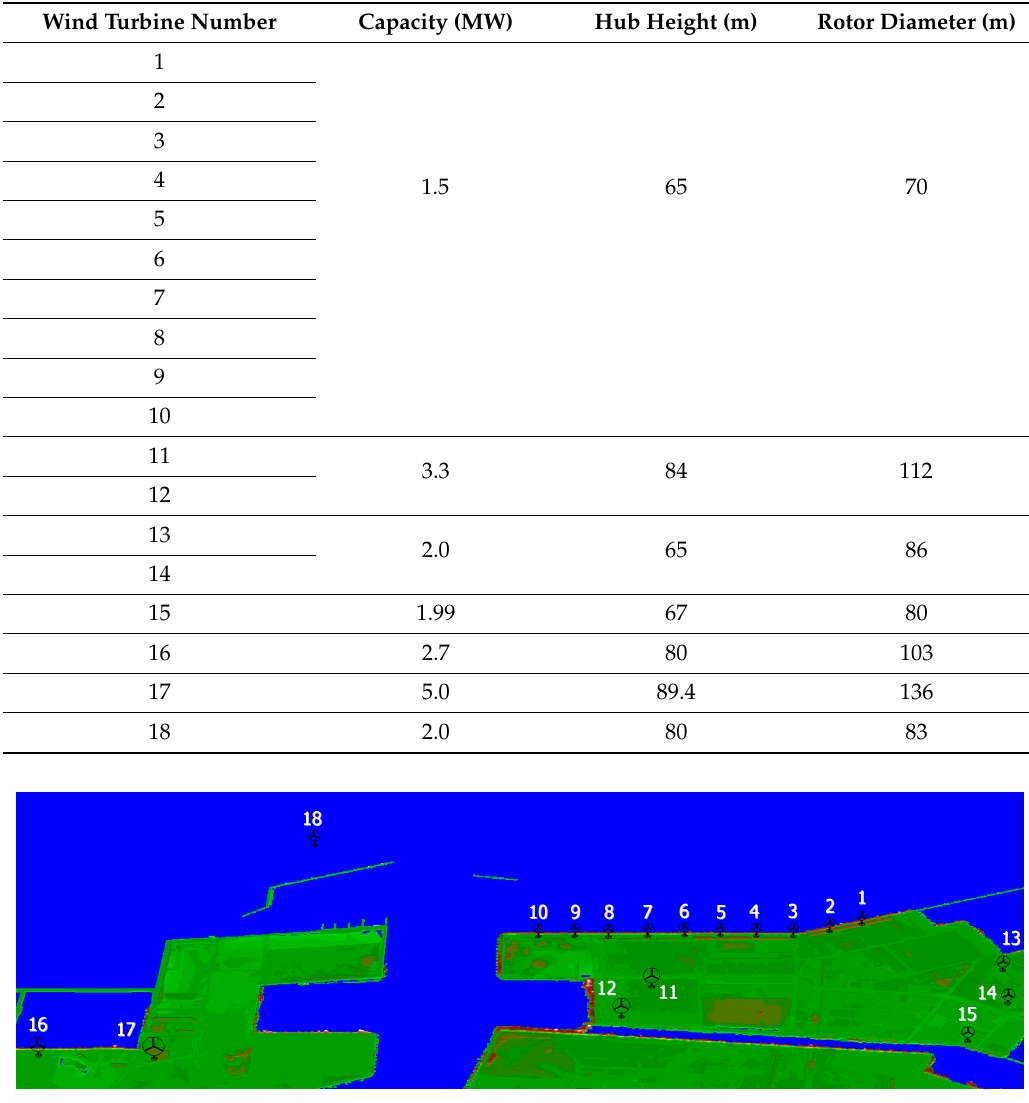
Table A1. Main specification information of each wind turbine.